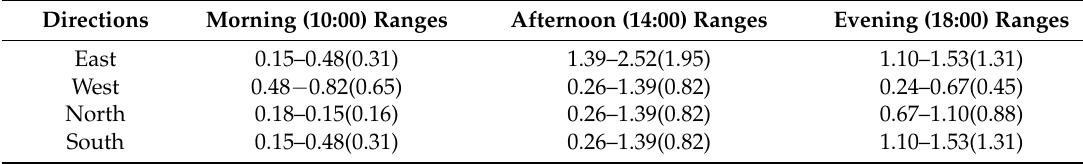
Table 4. Differences in T air at three time points in various directions under scenarios A and B.